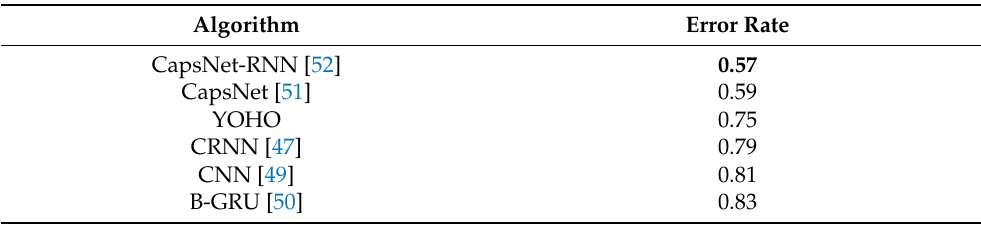
Table 7. Results on the TUT sound event detection dataset. The value in bold indicates the algorithm with the lowest error rate.